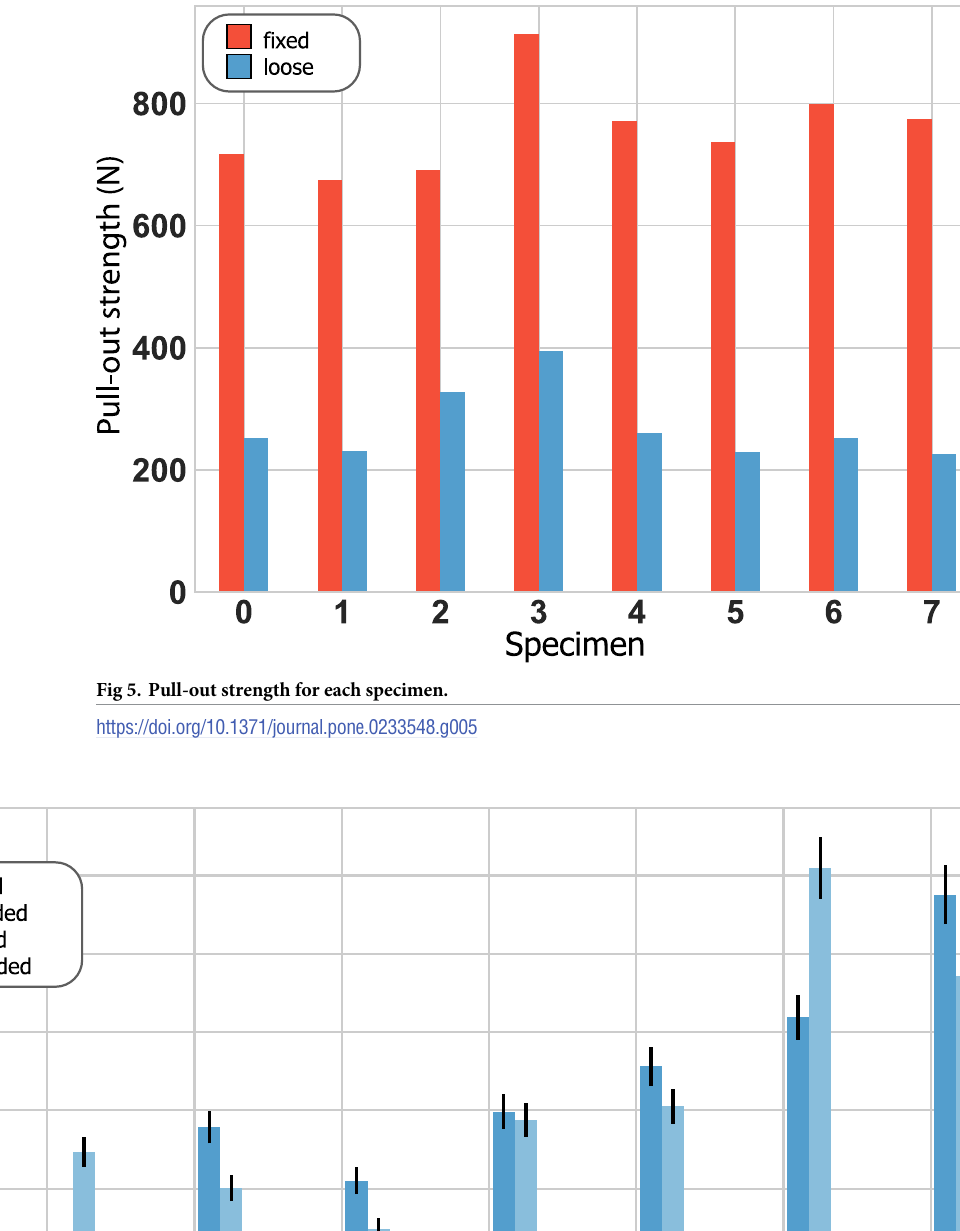
PLOS ONE | https://doi.org/10.1371/journal.pone.0233548 May 29,